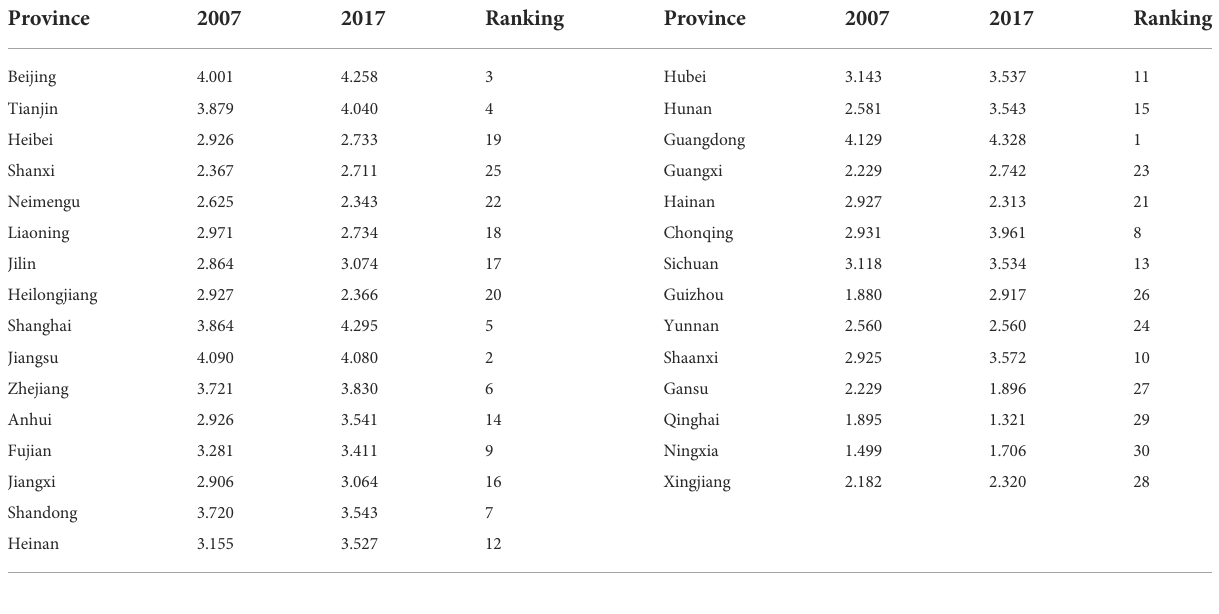
TABLE 4 Evaluation results of industrial green transformation index in 30 provinces (2007 – 2017).